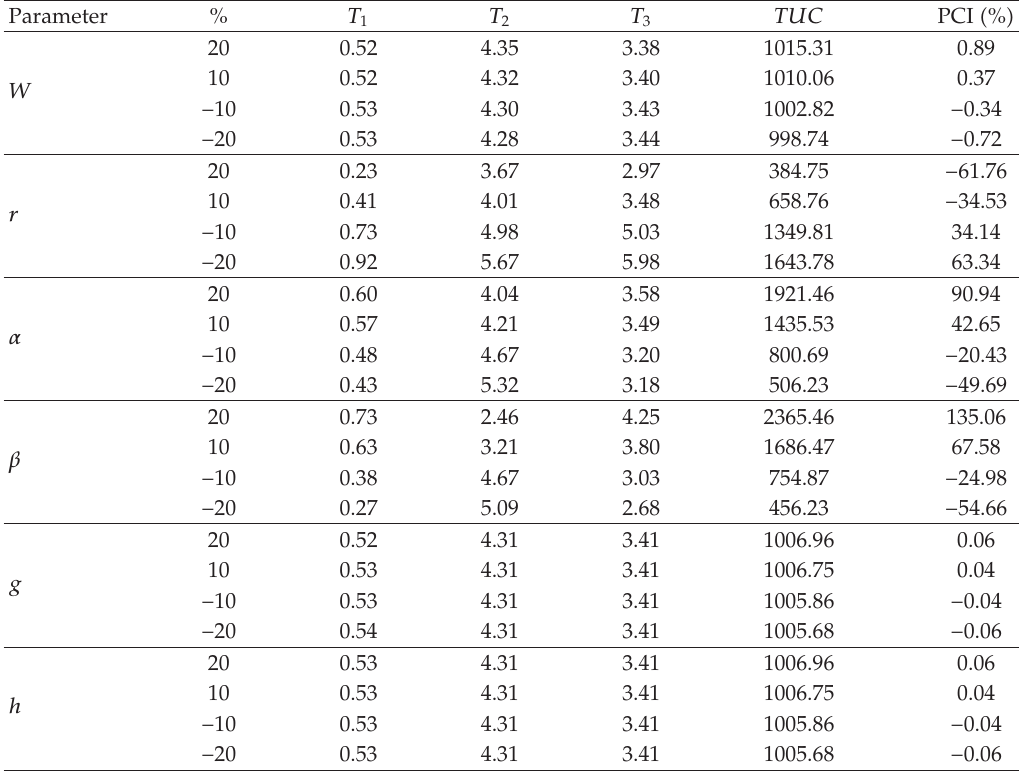
Table 2: The sensitivity analysis data showing various